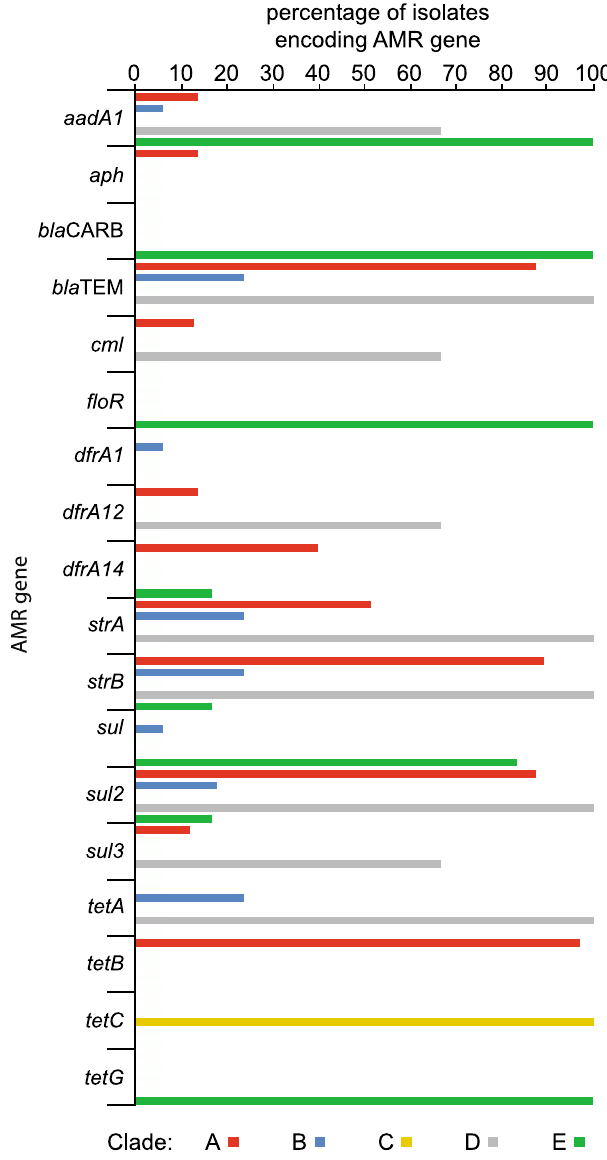
Figure 2. Distribution of antimicrobial resistance genes in the S . Typhimurium phylogenetic clades. Bars indicate the percentage of the isolates that encode each resistance gene. Clades correspond to those in Fig. 1. Clade A: S . 4,[5],12:i:- (n = 104), Clade B: S . Typhimurium (n = 17); clade C: S . Typhimurium (n = 7); clade D: S . Typhimurium U288 (n = 3); clade E: S . Typhimurium DT104 (n = 6). Genes identified were aadA1/aadA2 : aminoglycosides resistance gene; aph : aminoglycosides resistance gene; blaCARB : carbenicillin resistance; blaTEM : penicillins/early cephalosporins resistance; cmI : chloramphenicol resistance; floR : florfenicol/ chloramphenicol resistance gene; dfrA1 / dfrA12 / dfrA14 : trimethoprim resistance; strA / strB : streptomycin resistance genes; sul1/sul2/sul3 : sulphonamide resistance genes; tetA / tetB / tetC / tetG : tetracycline resistance; mefA/mefB : macrolide, lincosamide and streptogramin B resistance; msrD : macrolide resistance; qacEDelta1/ qacH : quaternary ammonium